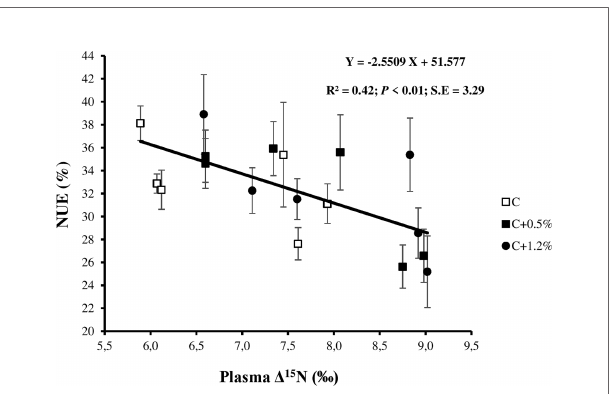
FIGURE 5 | Relationship between urine d 15 N and plasma d 15 N for individual observations of the sheep offered three different levels of non-protein N: C, control dietary treatment with maintenance N intake (NI) allowance; C+0.5%, control dietary treatment with maintenance plus an additional 15% NI allowance; C+1.2%, control dietary treatment with maintenance plus an additional 33% NI allowance. The error bars show